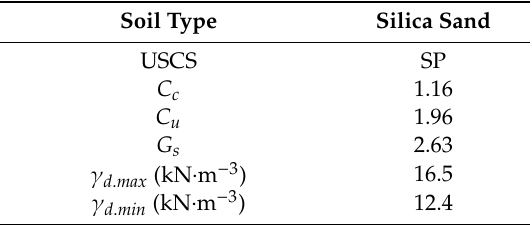
Table 4. Properties of silica